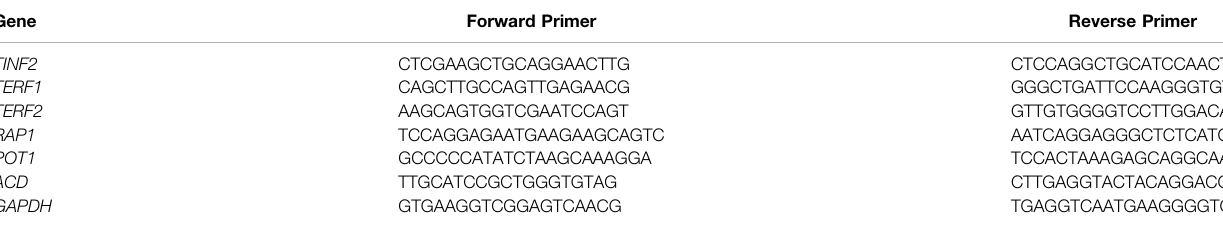
TABLE 1 | The primer sequences used for the